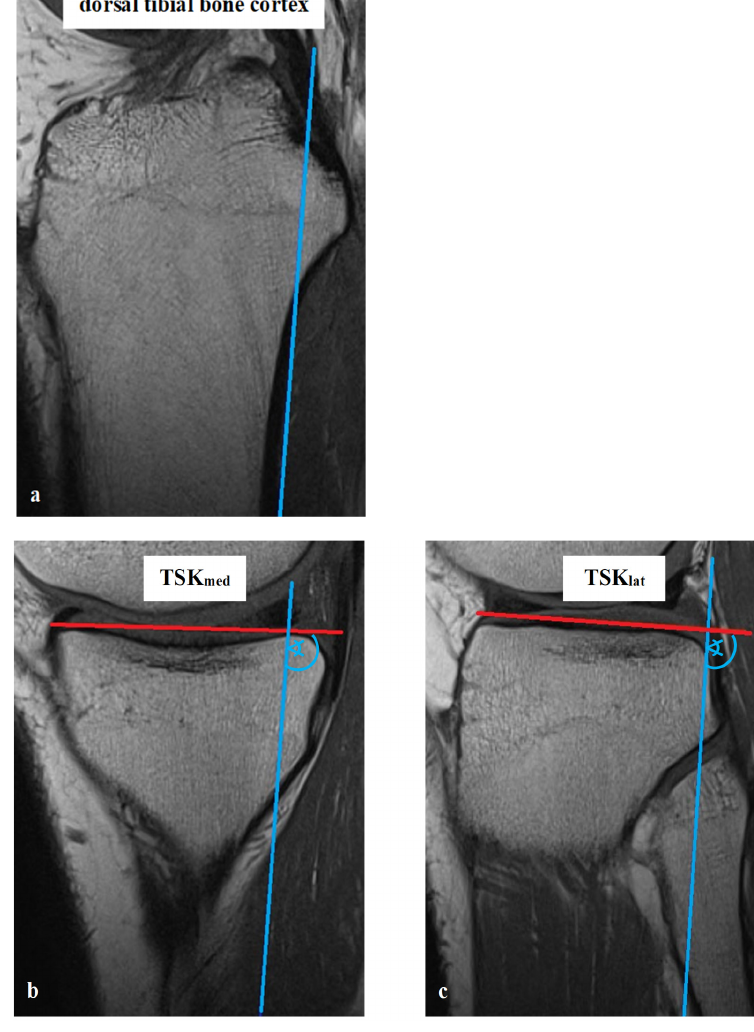
Figure 1. Exemplary depiction of the measurements of the tibial slope according to Karimi et al. [37] for medial (TSKmed, ( b )) and lateral (TSKlat, ( c )) knee-joint surface: The measurements of TSK were performed in sagittal view of the knee joint in MRIs. To determine the right position of the dorsal tibial bone cortex for each TSKmed and TSKlat, a reference line was set in the best available image ( a ). Based on this reference line, the dorsal inclination angle of the tibial plateau was determined in the medial (TSKmed, ( b )) and lateral (TSKlat, ( c )) joint sections.